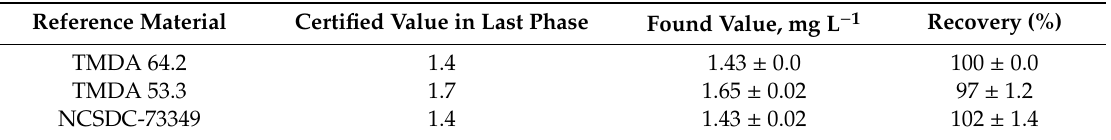
Table 2. Validation of the DES-ME of Pb(II) from the certified reference material ( n = 3). Reference Material